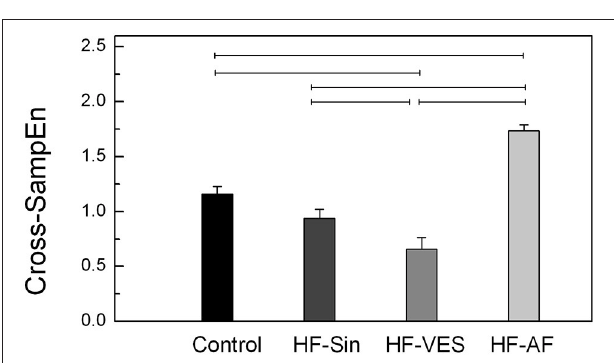
FIGURE 3 | Cross-sample entropy (Cross-SampEn). Lines denoted significant difference, p <